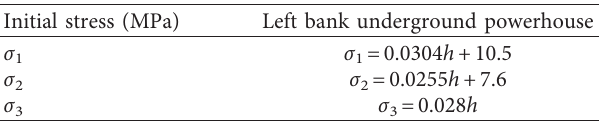
Table 3: Initial stress distribution of the left bank underground powerhouse